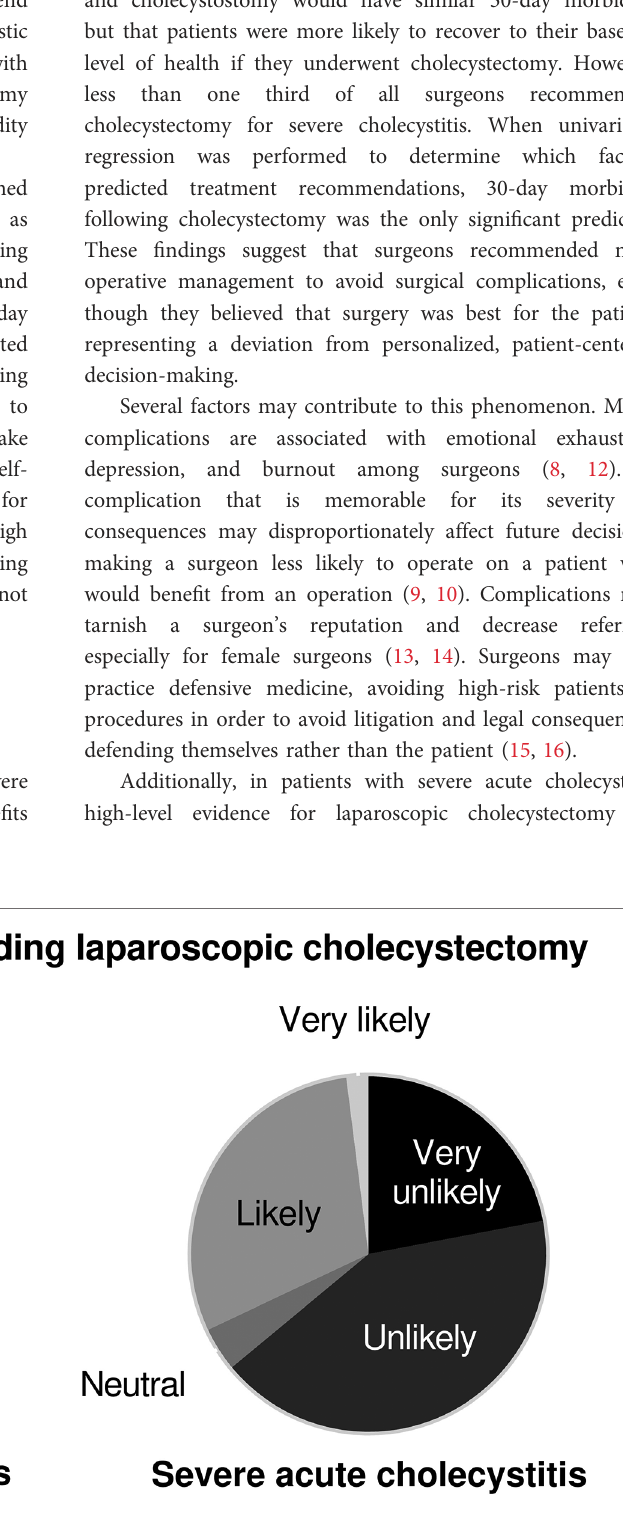
FIGURE 3 Surgeons were more likely to recommend laparoscopic cholecystectomy for patients with moderate acute cholecystitis compared with severe cholecystitis (98% vs. 32%, p